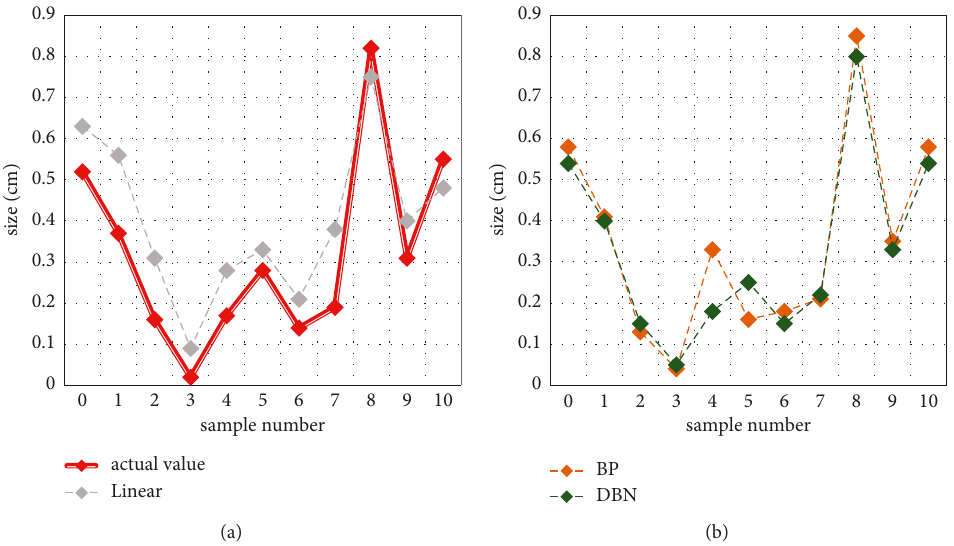
Figure 10: Cuff size of different algorithms: (a) The cuff data is not normalized (b) The cuff data is normalized.